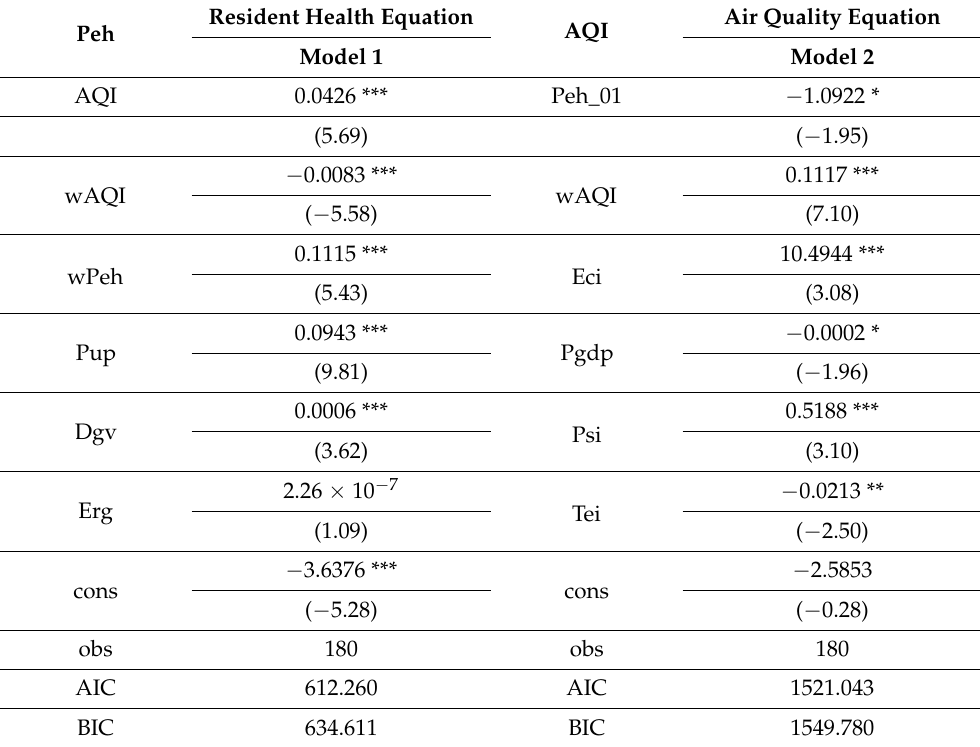
Table 1. Results of spatial simultaneous